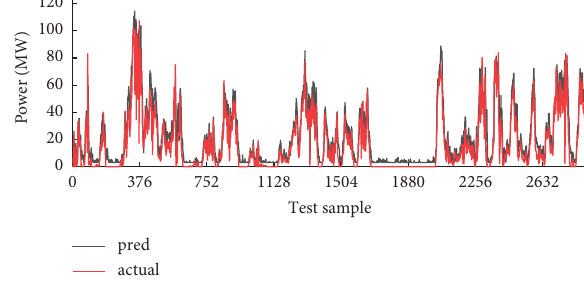
Figure 6: Te 16th step prediction curve of HM. Table 1: Predicted performance of HM.